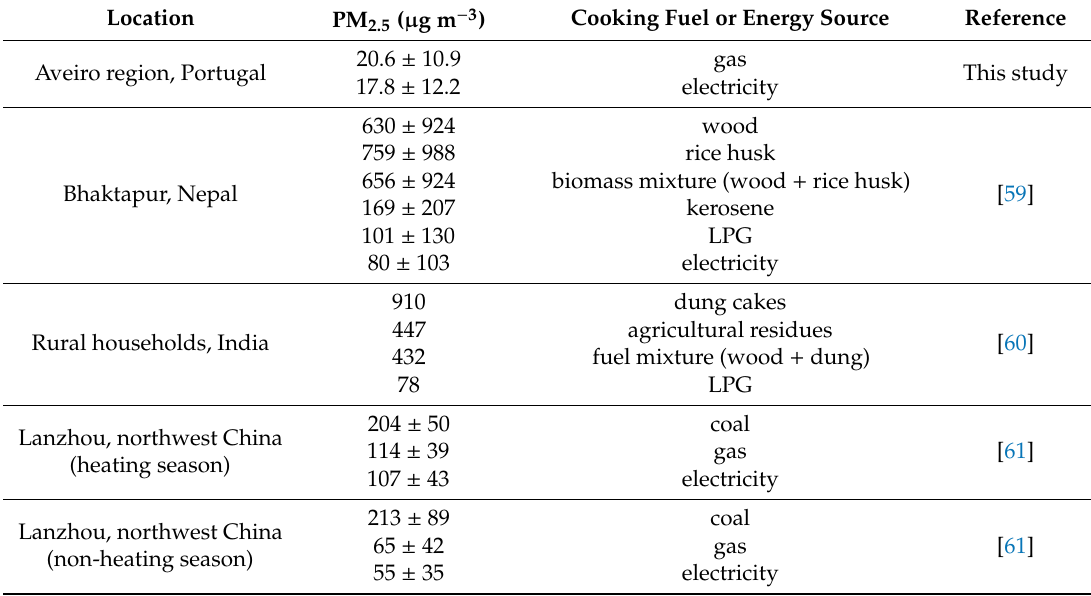
Table 5. PM 2.5 concentrations measured in the present study and in kitchens of other countries using di ff erent cooking fuels or energy